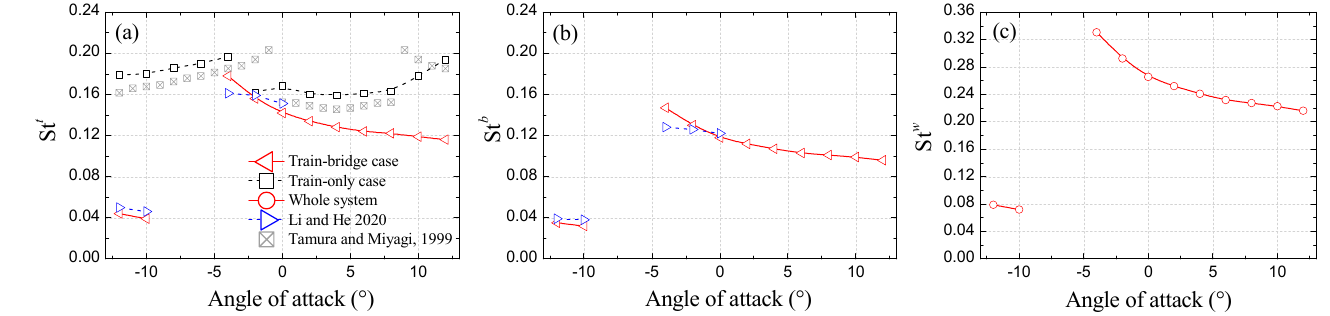
Figure 10. Strouhal numbers of the models: ( a ) the train model; ( b ) the bridge-deck model; and ( c ) the whole